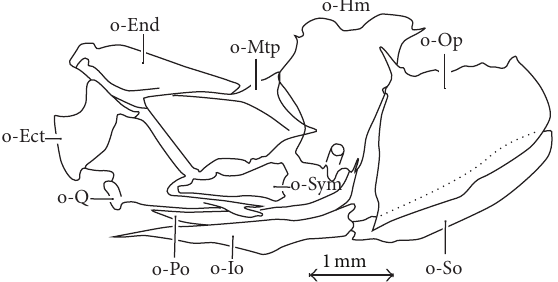
Figure 6: Medial view of the suspensorium of Oxynoemacheilus chomanicus . Apl: autopalatine; Ect: ectopterygoid; End: endoptery- goid; Hm: hyomandibular; Io: interopercle; Mtp: metapterygoid; Op: opercle; Po: preopercle; Q: quadrate; So: subopercle;